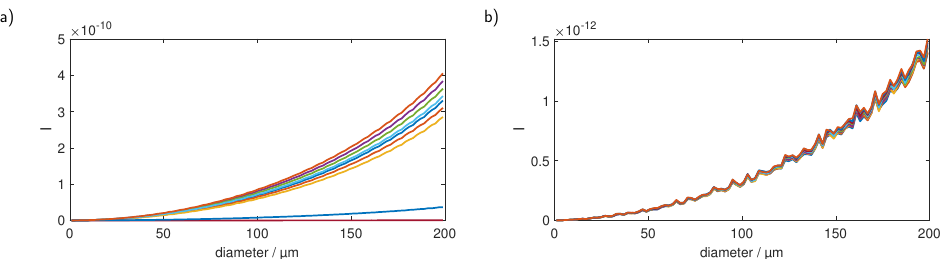
Figure 4. MC simulation of a fiber detector positioned in 5 mm distance to the cuvette at ( a ) 30 ◦ and ( b ) 90 ◦ . Each color corresponds to a different particle position.